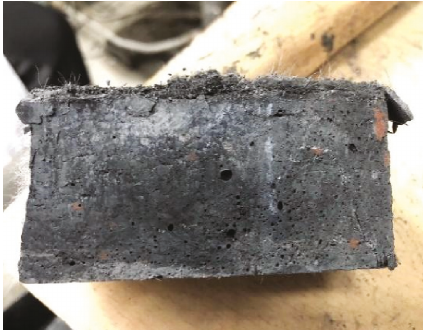
Figure 6: Appearance and curves of specimens under compressive failure in normal experimental